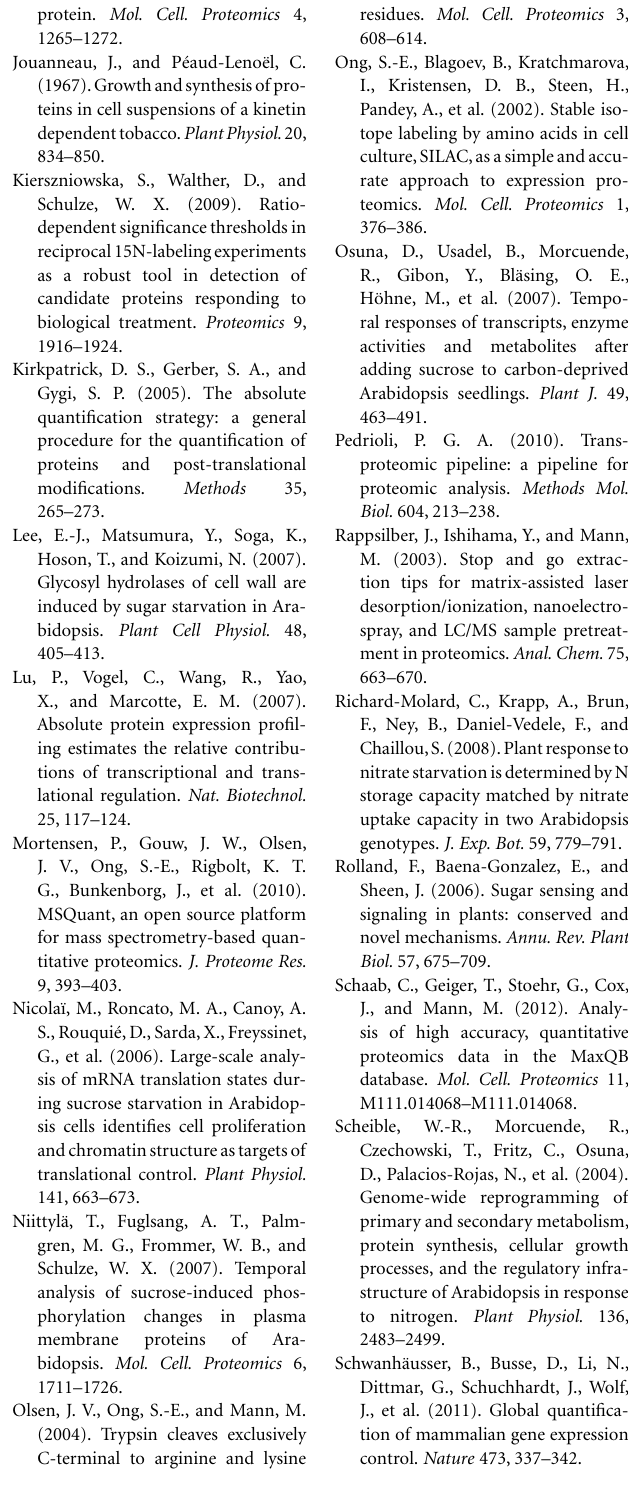
Reference protein normalization